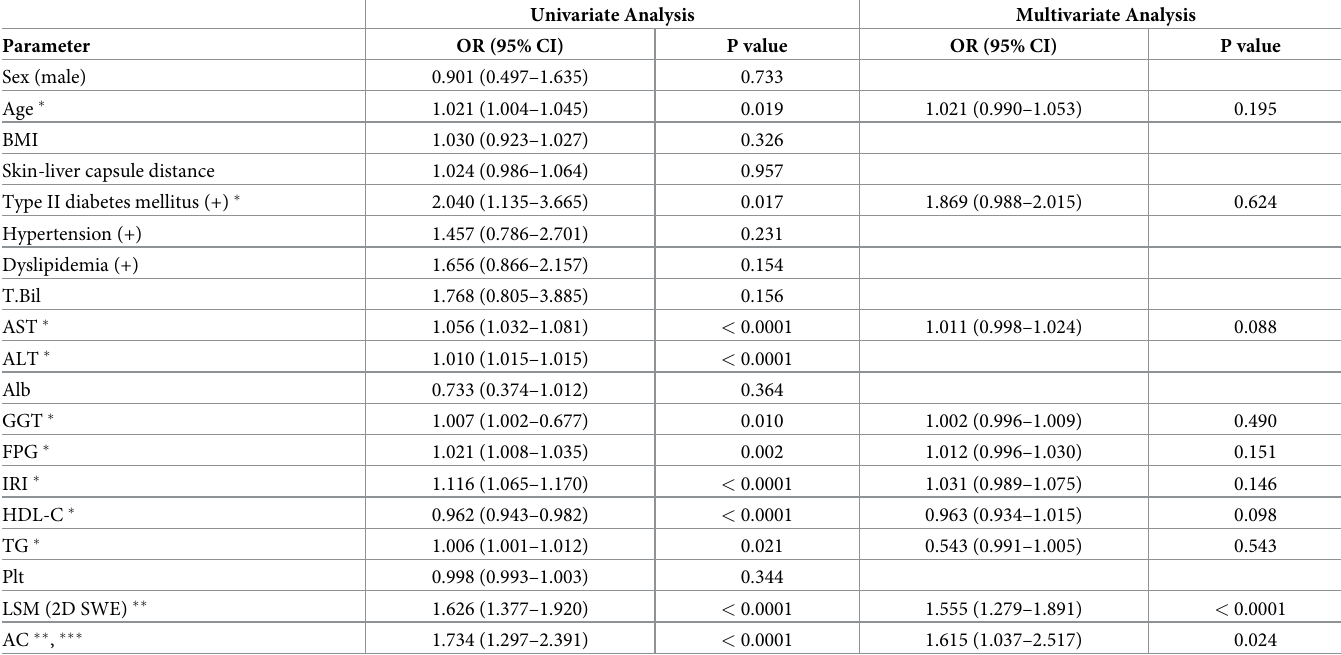
Table 4. Predictive factors for progressive NASH, as assessed using univariate and multivariate regression